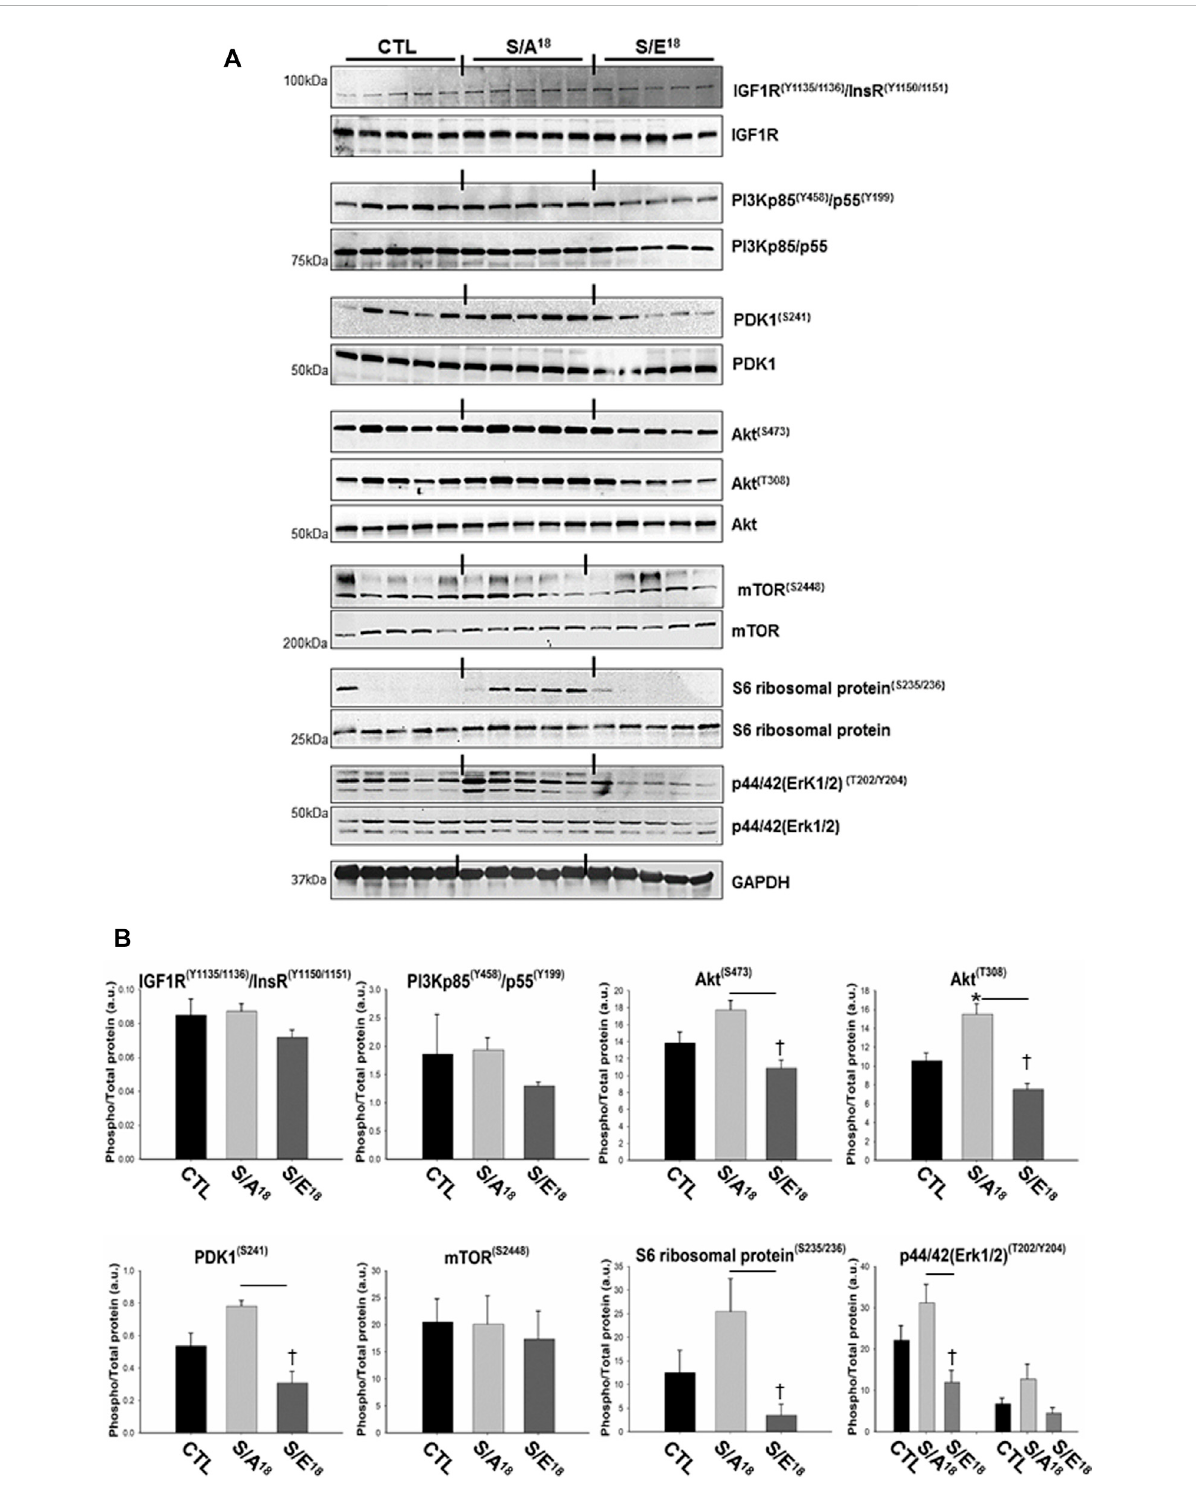
FIGURE 3 Analysis of the IGF-1R signaling pathway in the hearts of peptide treated mice at 4.5 mg/kg/day dose. (A) . Immuno-blots showing phosphorylation of IGF-1R pathway signaling proteins. (B) . Quanti fi cation of phospho-protein signaling relative to non-phosphorylated proteins (* p < 0.05, vs. CTL and † p < 0.05 vs. peptide at same dose, n =